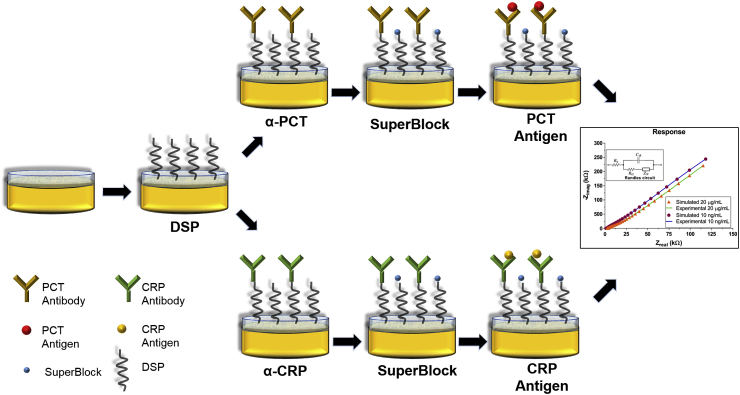
Schematic representation of the immunoassay building protocol for dual marker biosensing platform.